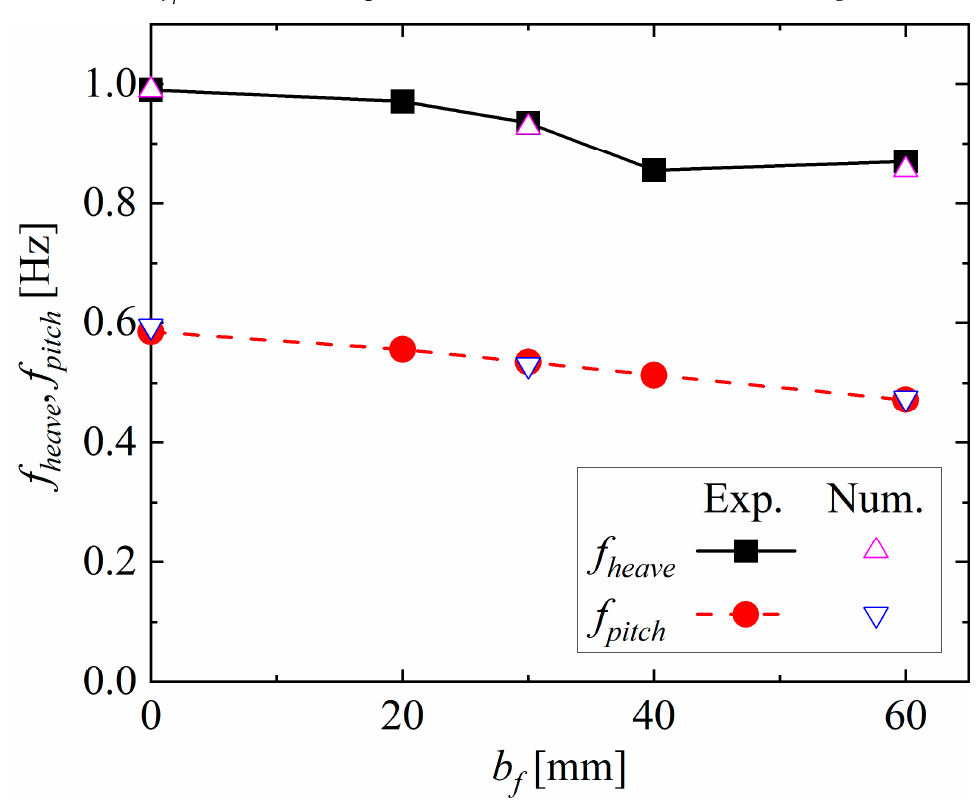
Figure 14. Comparison of the natural frequency of the heave f heave and pitch f pitch .